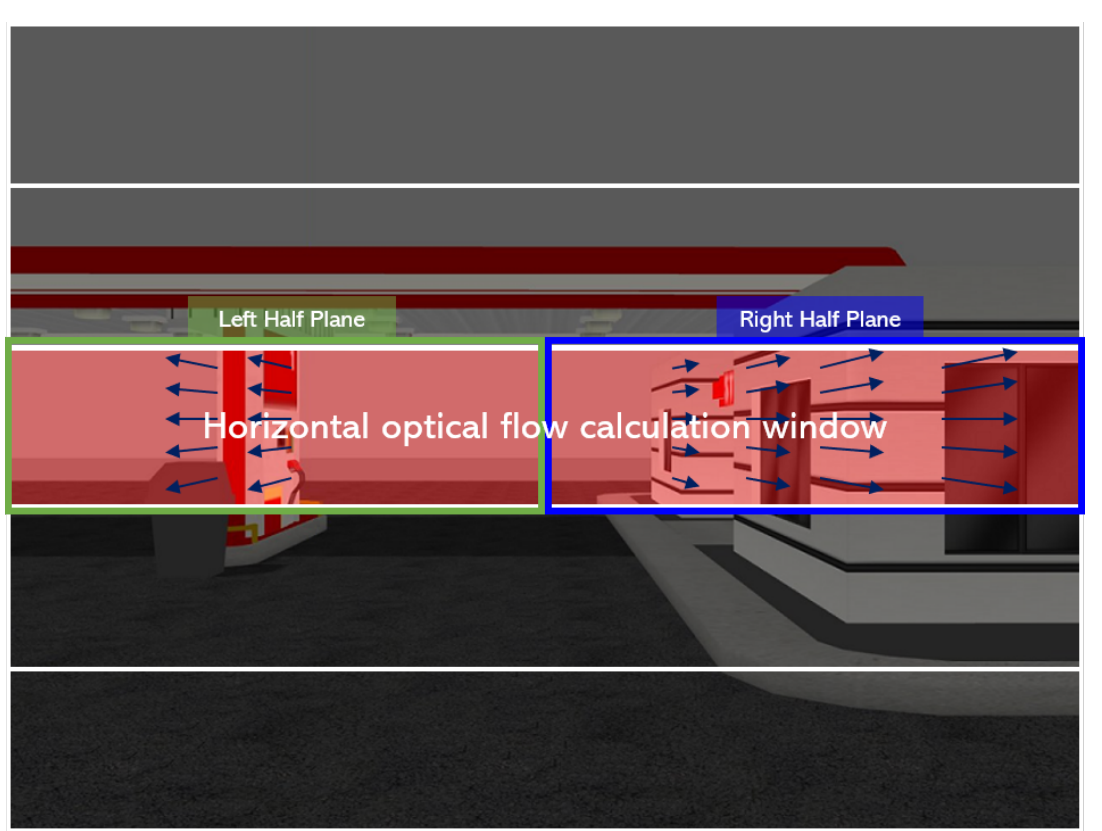
Figure 3. Horizontal optical flow calculation